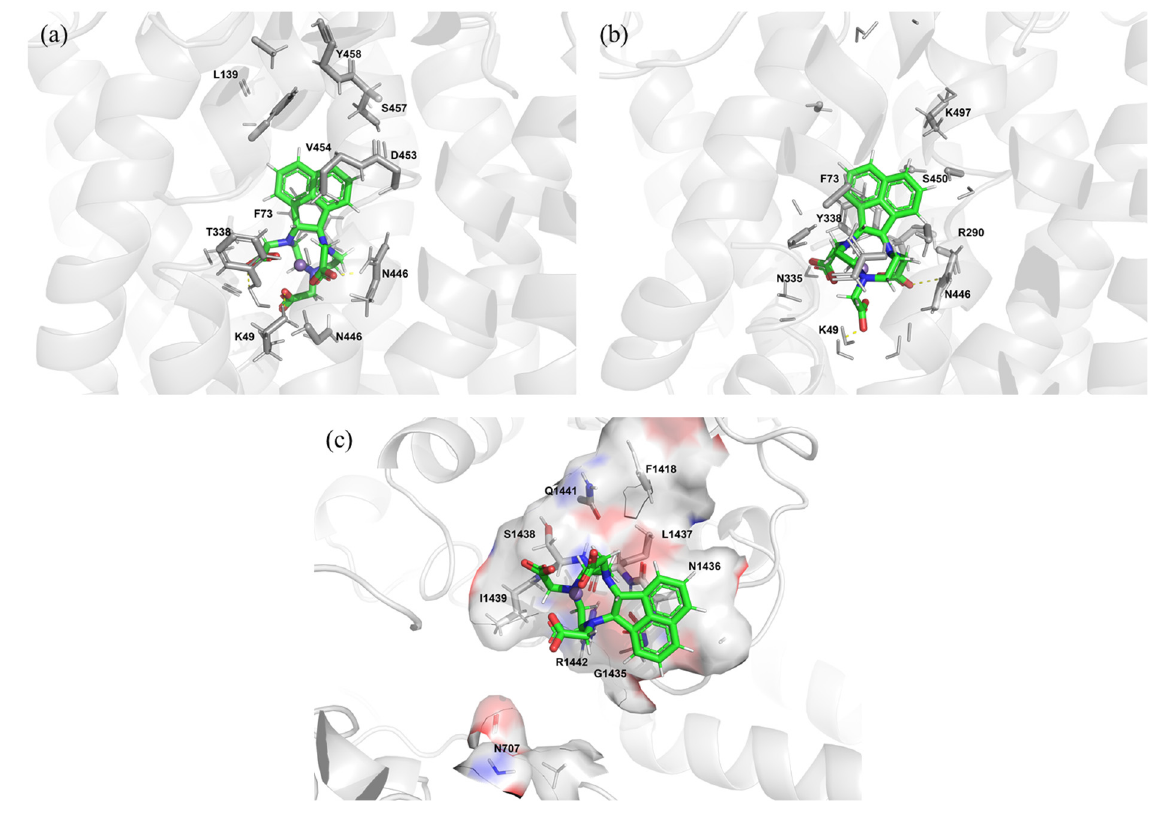
Figure 2. Schematic representations of variable interactions between Mn-NOTA-NP and ( a ) OATP1B1, ( b ) OATP1B3, and ( c ) MRP2. The yellow line represents hydrogen bonds. Table 2. Docking scores for Mn-NOTA-NP , Mn-EDTA-BTA, Mn-EDTA-EOB, and Gd-DTPA-EOB with organic anion-transporting polypeptides (OATPs) and multidrug resistance-associated protein 2 (MRP2). Data expressed as